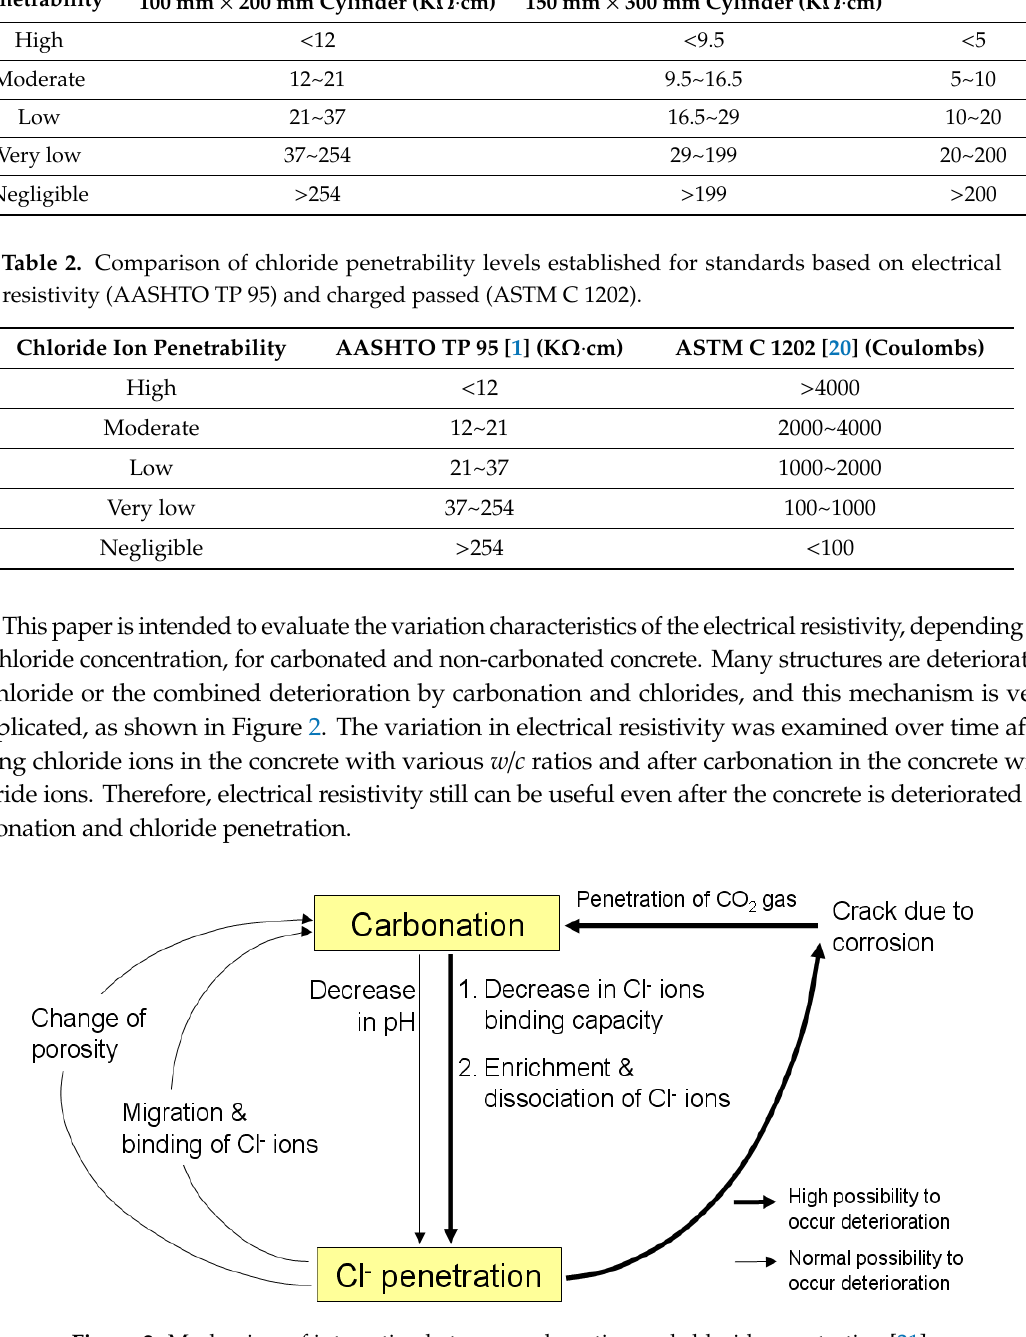
Figure 2. Mechanism of interaction between carbonation and chloride penetration [21].